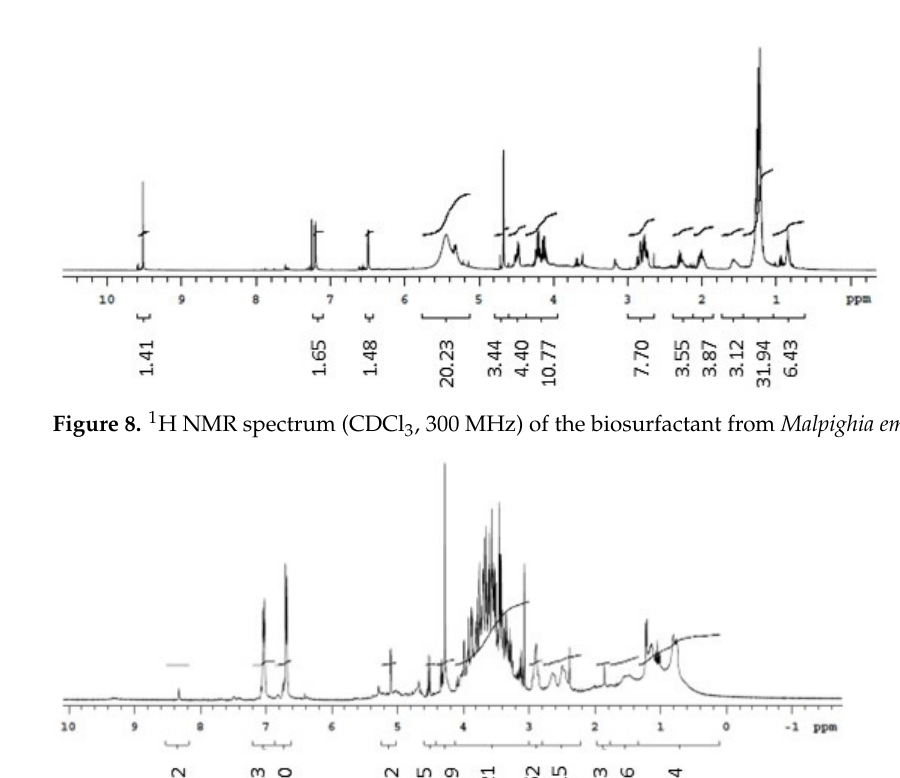
Figure 7. 1 H NMR spectrum (CDCl 3 , 300 MHz) of the biosurfactant from Glycine max.